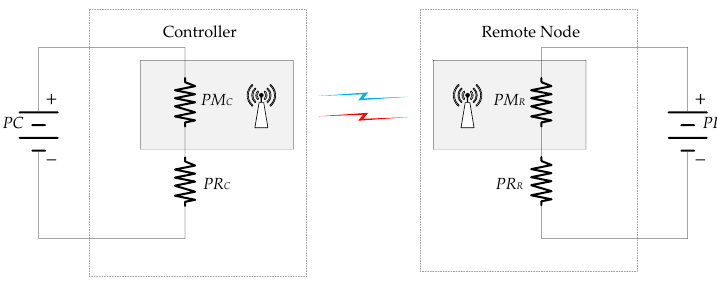
Figure 6. Energy model for the controller and for the remote